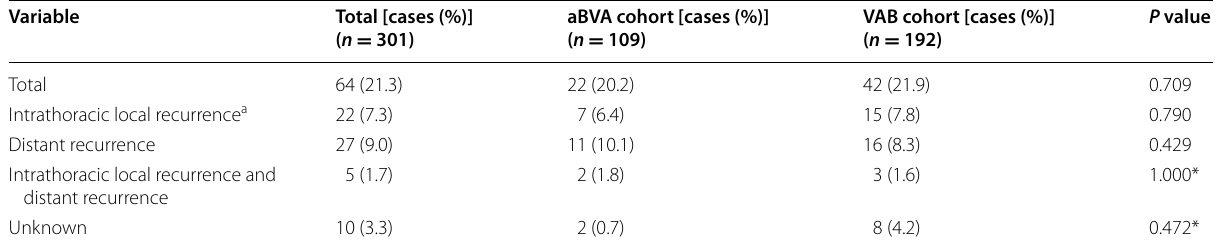
Table 4 Comparison of recurrence models in patients with disease recurrence between the aBVA and VAB cohorts